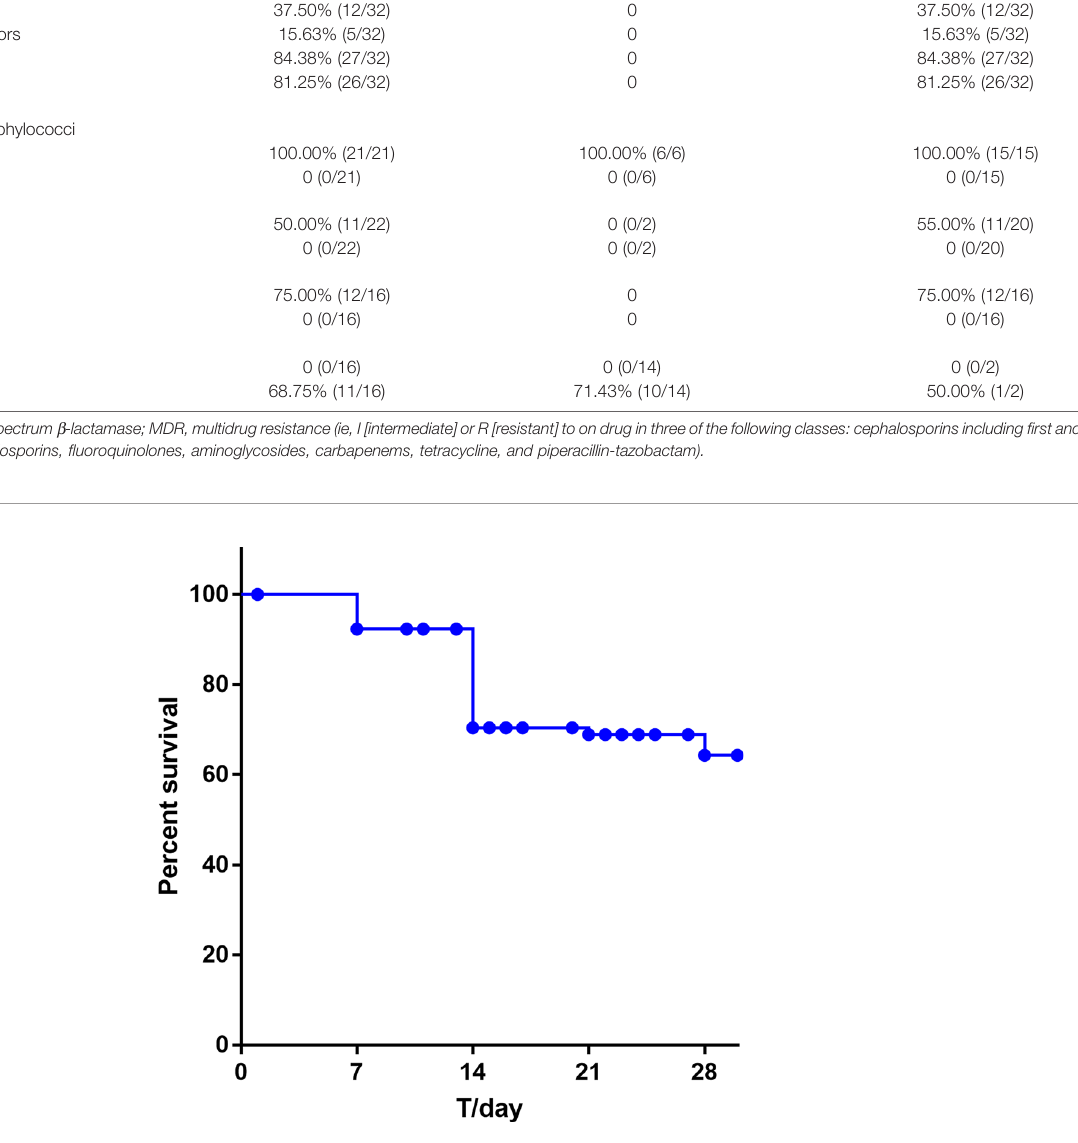
FIGURE 5 | Neonatal mortality at 28 days with